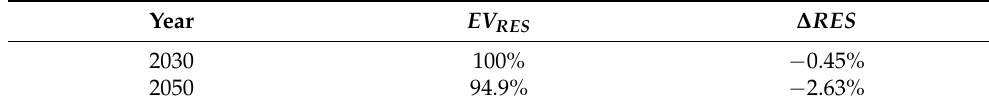
Table 1. EV charging ensured by RESs and impact on the total share of